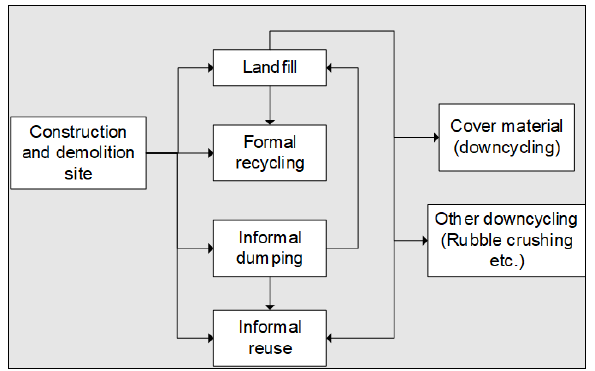
Figure 4: Construction and demolition waste value